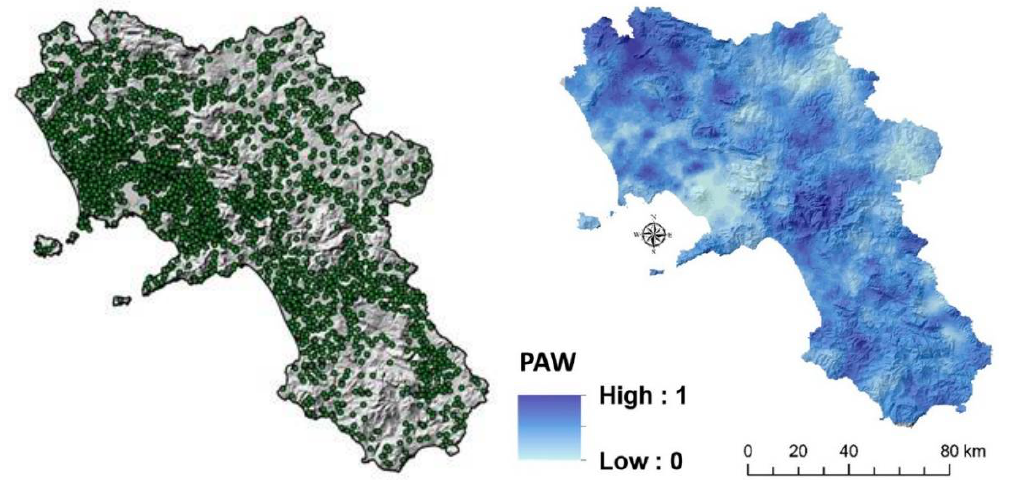
Figure 3. ( a ) The administrative territory of Campania (southern Italy; the area is about 13,671 km 2 ) with the green circles showing the topsoil sampling locations. ( b ) The regional map of plant-available soil water (PAW) obtained by using measured soil physico-chemical properties and pedotransfer functions (PTFs).